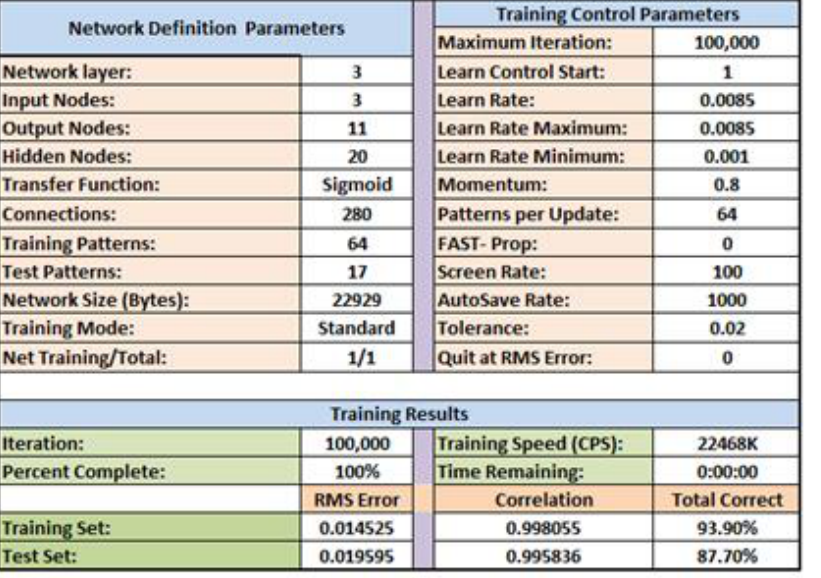
Figure 2. Network definition and training control parameters of the best topology of the ANN model (3-20-11) to predict quality attributes of Flame Seedless grape berries cultivated under various agronomical management and other practices acquired from Qnet2000 software.